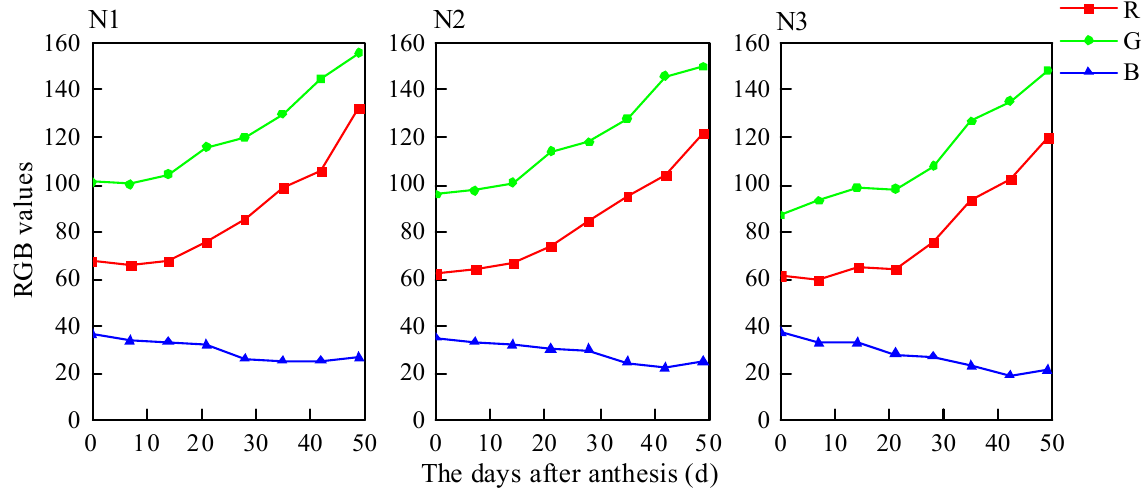
Figure 4. Dynamic changes in leaf RGB values with high, medium, or low nitrogen supplies in CY5 after anthesis.